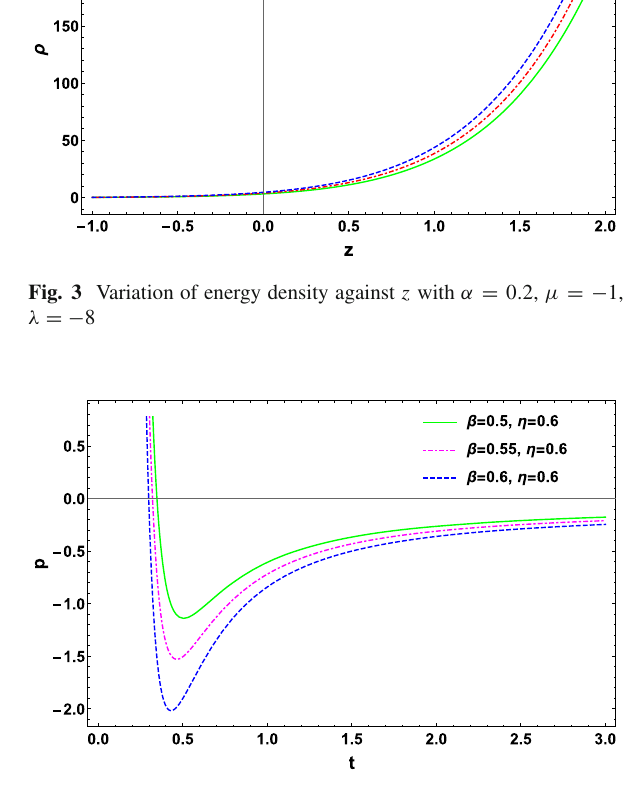
Fig. 4 Variation of pressure against time with α = 0 . 2, μ = − 1, λ = − 8